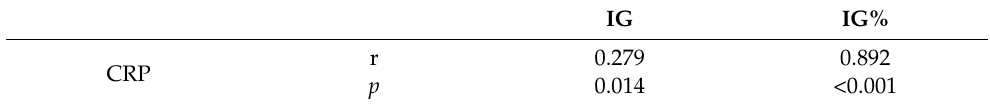
Table 3. Evaluation of correlation between CRP, IG, and IG% values.